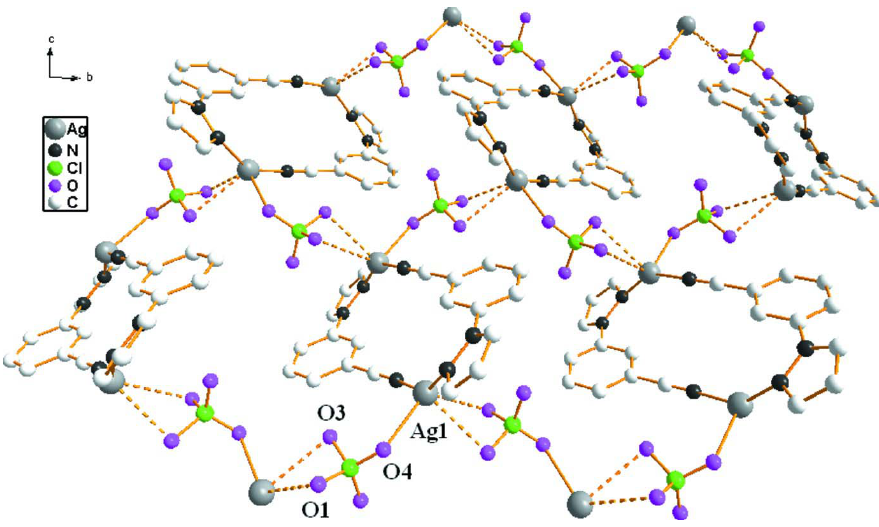
Figure 2 Part of the crystal structure of (I). Dashed lines show weak Ag···O interactions. The minor component of disorder is not shown.